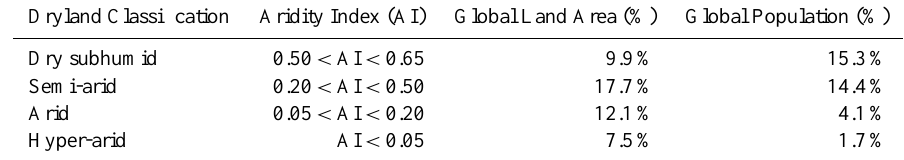
Table 1. The classification, percentage of global land area and percentage of global population of each dryland type. Data are from United Nation’s Millennium Ecosystem Assessment (2005) and Gilbert